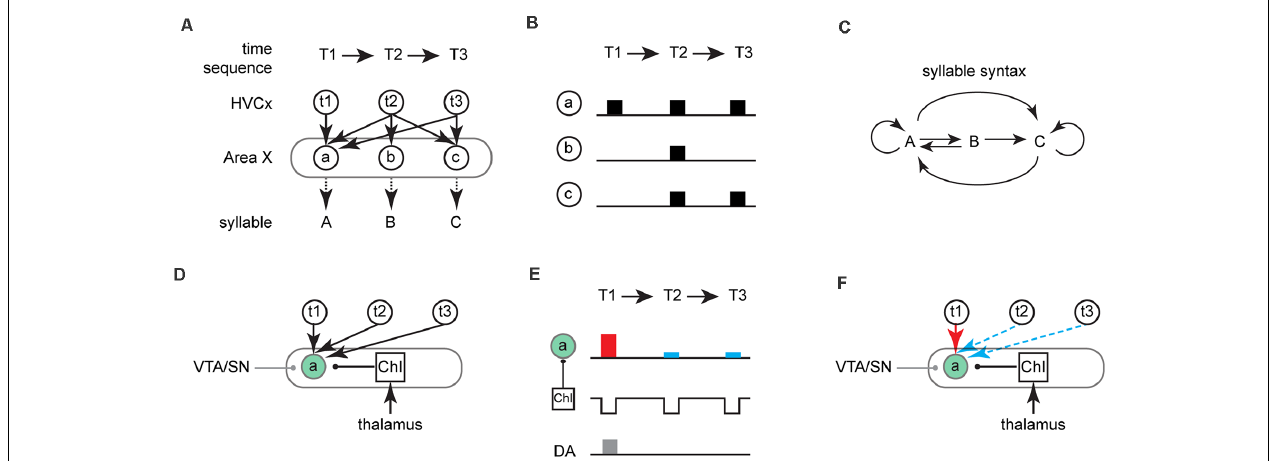
FIGURE 2 | A gated-reinforcement learning model for sequence learning. (A) A schematic of the model for a three time-step (T1 → T2 → T3) song motif. Three ensembles of MSNs (a/b/c) in Area X (gray circle) are involved in learning the sequence of corresponding vocal elements (labeled as syllable A/B/C). MSN ensembles receive inputs from the ensemble of HVC neurons (HVCx, labeled as t1/t2/t3), each of which is active at the corresponding time-steps (T1–T3). Arrows between HVCx and an individual ensemble of MSNs indicate their synaptic connections and correspondent weights. In this hypothetical scenario, the probability of ensemble “a” of MSNs being activate is equal across all three time-steps for a given rendition of the song motif. This contrasts with ensemble “b” which can be activated exclusively at T2 or ensemble “c” which can be activated at either T2 or T3. (B) Theoretical neural activity in MSN ensembles (a/b/c) in Area X at different time steps given the corticostriatal connections shown in (A) . (C) Syllable syntax map showing the potential syllable transitions that could result from activity patterns across MSN ensembles in Area X shown in (B) . For instance, if ensemble “a” of MSNs is activate at all three time-step in one rendition, syntax “AAA” is produced. In another rendition, if ensemble “a” is activate at T1 and ensemble “c” is activated at T2 and T3, syntax “ACC” is produced. Arrows between different syllables indicate the corresponding transitions. Circle arrows besides “A” or “C” indicate repetition of the given syllable. (D) Schematic of the three inputs to the MSN ensemble “a”: VTA/SN, HVC, and ChIs. The square represents ChIs whose pauses are associated with syllable “A”. The green circle indicates that ensemble “a” is being depolarized at the same time that there are pauses in the activity of ChIs projecting onto ensemble “a”. Arrows indicate glutamatergic inputs from either HVC or DLM (thalamus). Lines with a circle at the end indicate modulatory inputs from either VTA/SN (gray, DA) or ChIs (black, Ach). (E) Schematic of gated-reinforcement learning. ChIs pauses are coincident with activation of ensemble “a” (green circle) while phasic dopamine signal (DA, gray rectangle) is active at T1. LTP (red rectangle) results at T1 when MSNs depolarization is coincident with ChIs pause and phasic increases in DA; LTD (blue rectangle) results at T2/T3 when MSNs depolarization is coincident with ChIs pause in the absence of phasic increases in DA. (F) Given the coincident activity of MSNs depolarization, cholinergic pauses and phasic increase in DA shown in (E) , LTP (red arrow) results at “t1 → a” synapses and LTD (blue dashed arrow) results at “t2 → a” and “t3 → a” synapses.